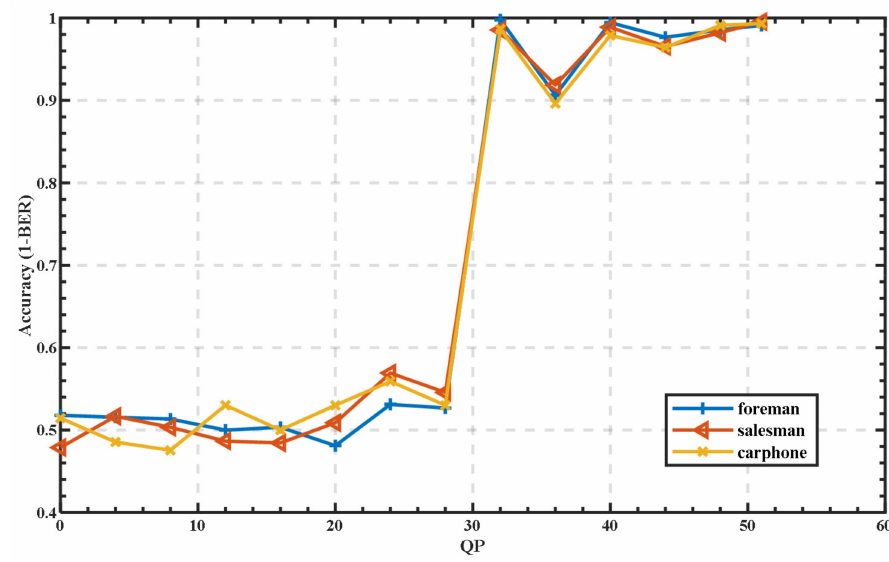
Figure 10. Accuracy of information extraction under QP = 40 re-compression